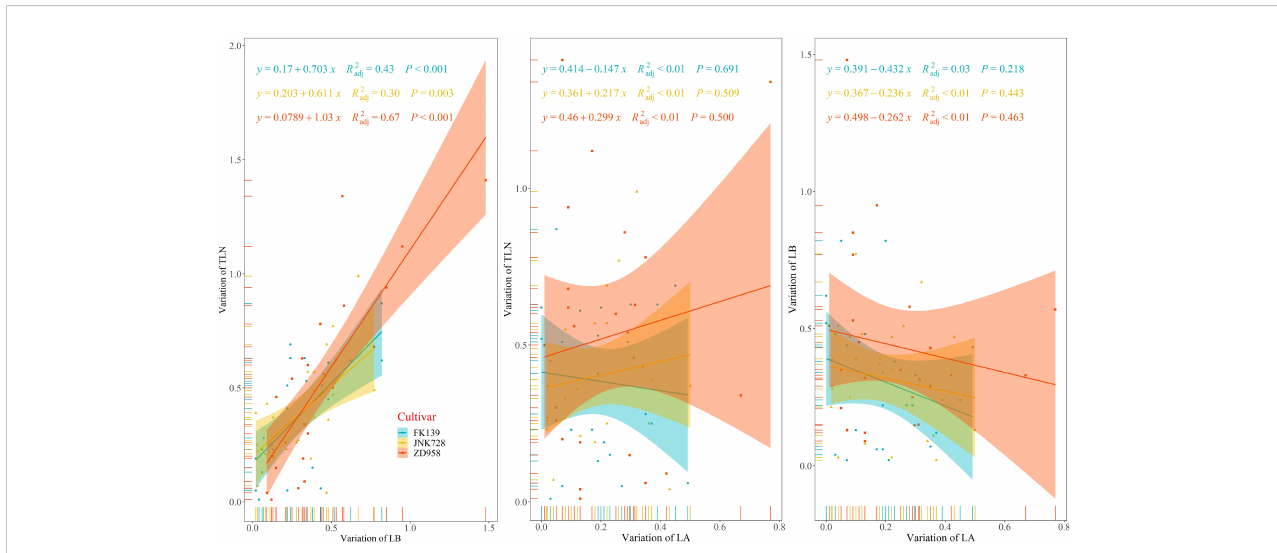
FIGURE 5 Relationships between variations in leaf number variables. Variation of LA is the absolute value of LA of a treatment minus the average value of LA of a cultivar; variation of LB is the absolute value of LB of a treatment minus the average value of LB of a cultivar; and variation of TLN is the absolute value of TLN of a treatment minus the average value of TLN of a cultivar. R 2 adj , adjusted R